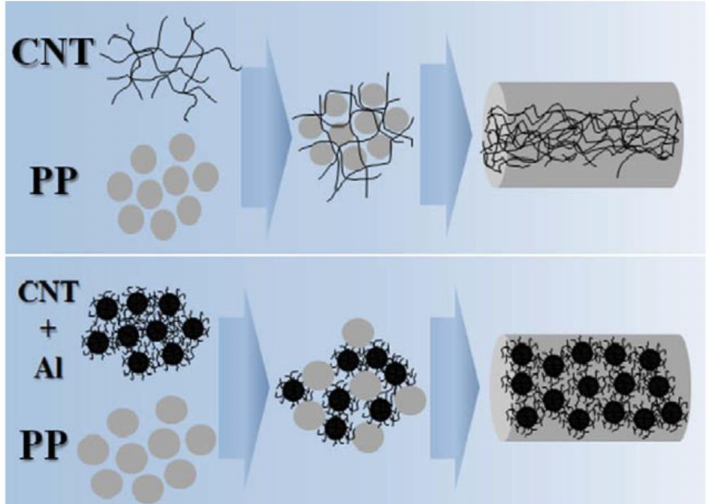
Figure 6. The schematic diagrams showing the dispersion of CNTs into the PP matrix [97]. Re- produced with permission from Ref. [97]. Copyright (2010), Composites Part A: Applied Science and